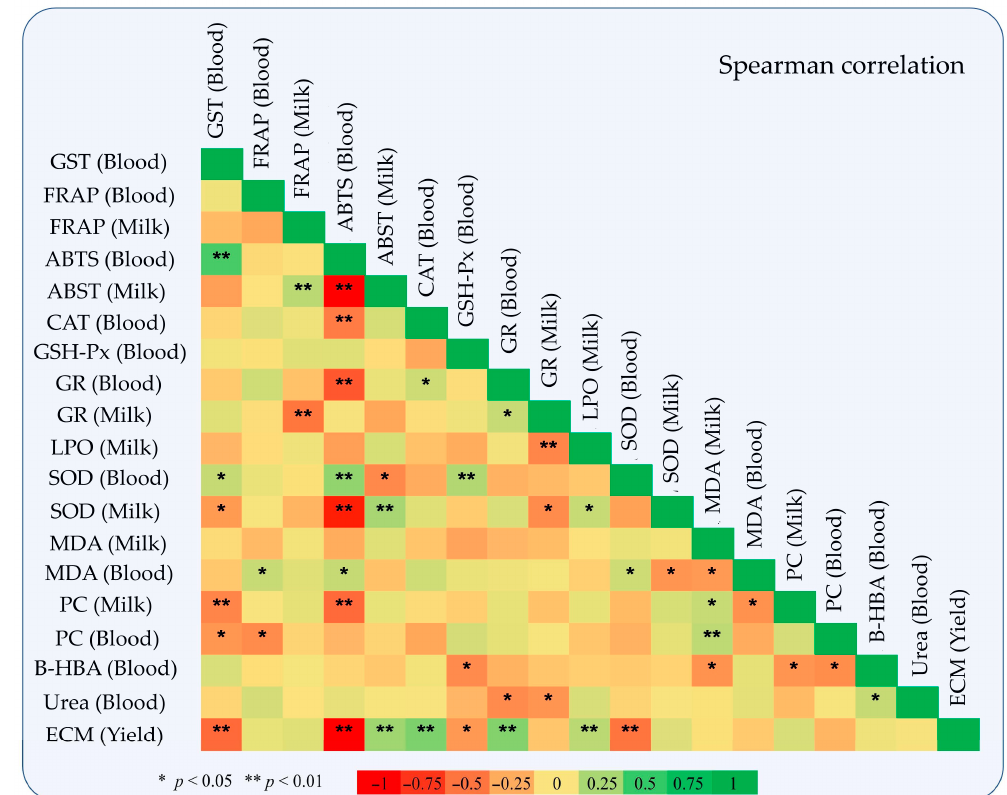
Figure 4. Spearman correlation depicts correlations between oxidative status in blood plasma and milk, b-hydroxybutyrate acid and urea concentration in blood, and ewes’ energy corrected milk yield.